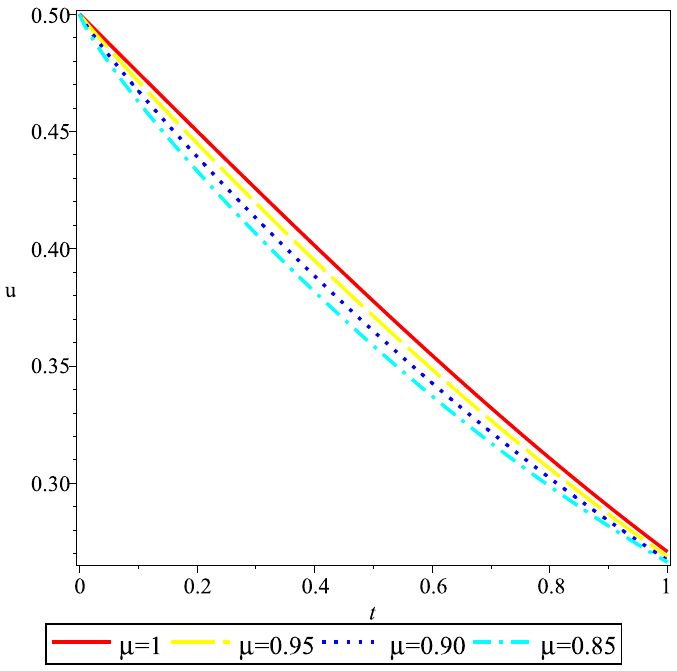
Figure 5. Response of u ( t ) with respect to t for distinct values of µ